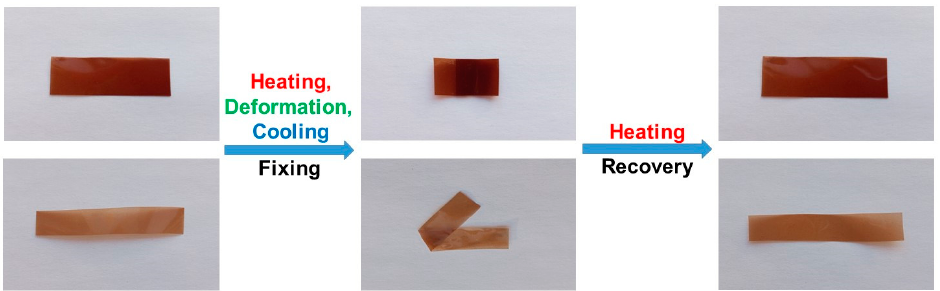
Figure 7. The shape-memory process of C10-PBI ( top ) and C14-PBI ( bottom ).